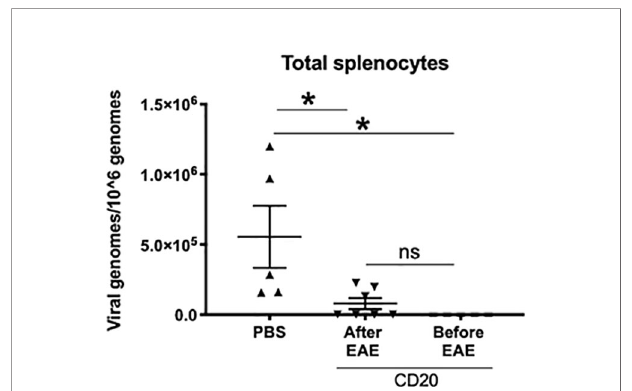
analyzed with Student ’ s t-test: *p < 0.05. ns = not signi fi